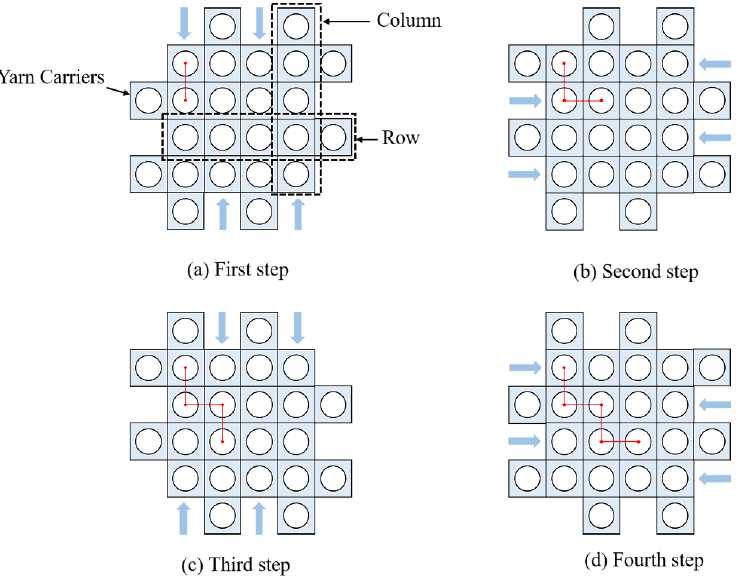
Figure 1. Schematic of four-step 1 × 1 braiding process, ( a ) First step, ( b ) Second step, ( c )Third step, ( d ) Fourth step.